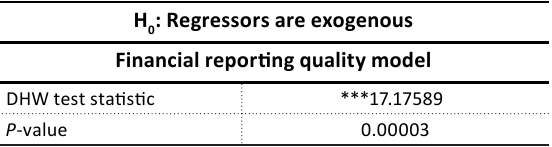
Table 5. The Durbin-Wu-Hausman test for endogeneity of regressors